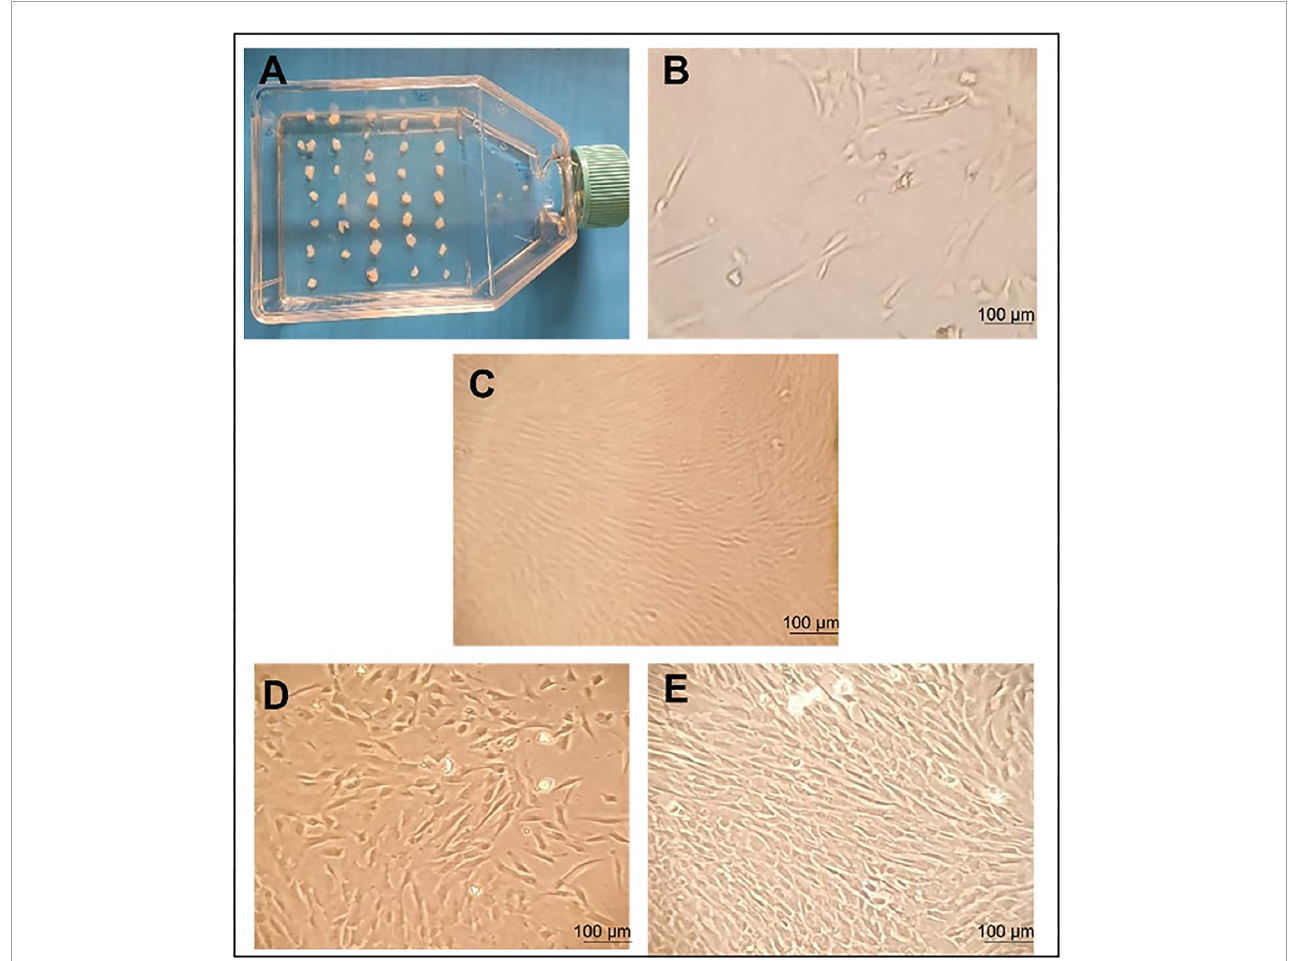
FIGURE2 Umbilical cord tissue mesenchymal stem cells morphology and proliferation. Morphology of human mesenchymal stem cells (MSCs) observed using an inverted microscope. (A) initial day; incubation of 1–2 mm tissue in a flask. (B) MSC grows out from tissue pieces 10 days after seeding. Fusiform cells began to form around the tissue and colonization was observed. (C) Growing colonies; a substantial number of cells exhibited a fibroblast-like morphology 14 days after seeding. (D) The proliferation of fibroblastic cells 18 days after seeding. (E) The culture showed 80% confluent colonies 21 days after seeding. This is the image that shows the need to be passed to the P2 stage. Scale bars 100 µ m.